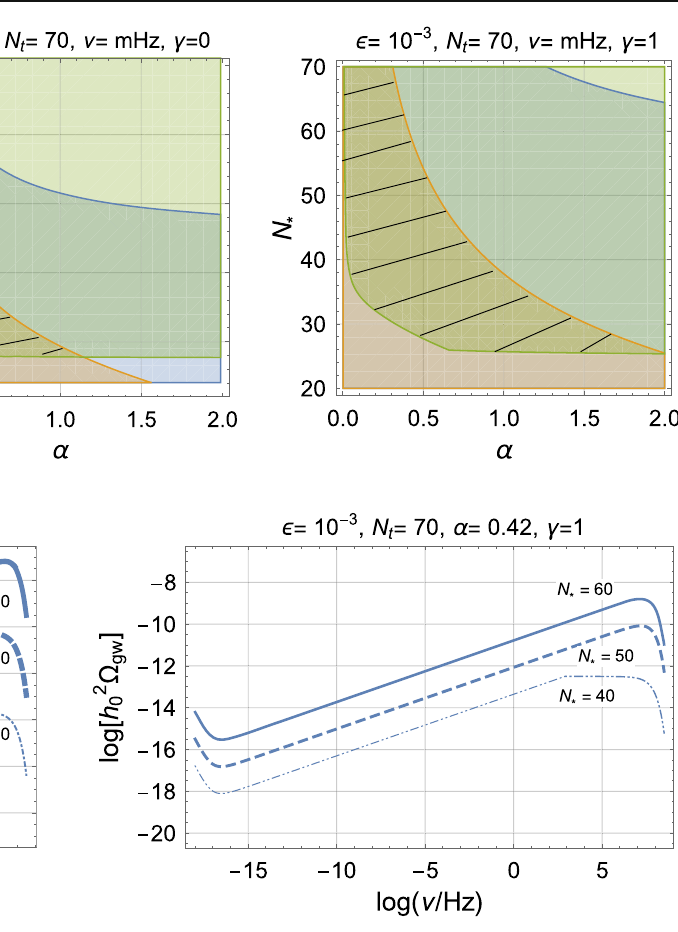
Fig. 11 The spectral energy density is illustrated for N ∗ < N t ; to compare this plot with the one of Fig. 10 we stress that α = 0 . 42 and γ =